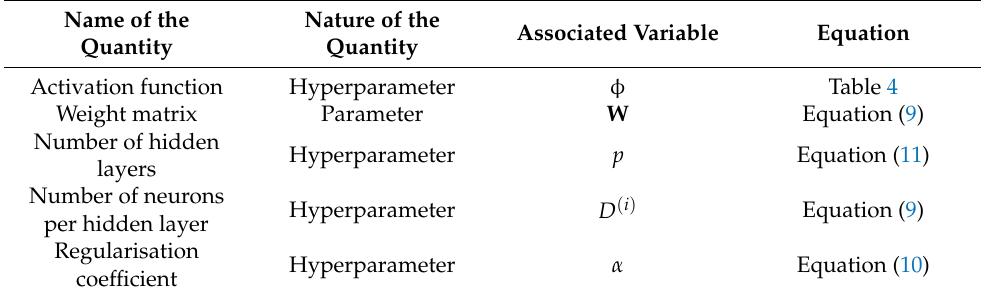
Table 5. DNN parameters and